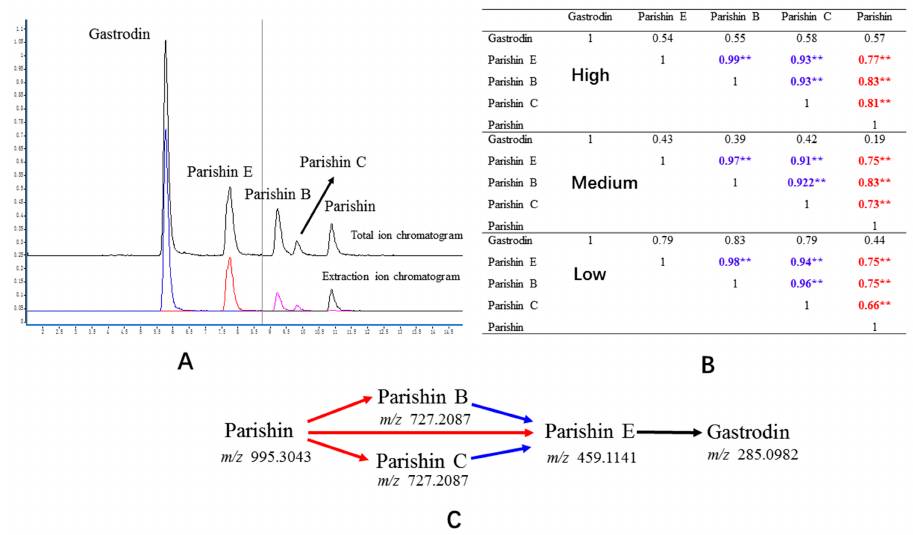
Figure 3. ( A ) The total ion mass spectrograms and extraction ion mass spectrogram of the potential compounds in beagle plasma after administration of tall Gastrodia capsules; ( B ) Correlation coefficients of five compounds (** represents p < 0.01); ( C ) Putative pathway from parishin to gastrodin in vivo.